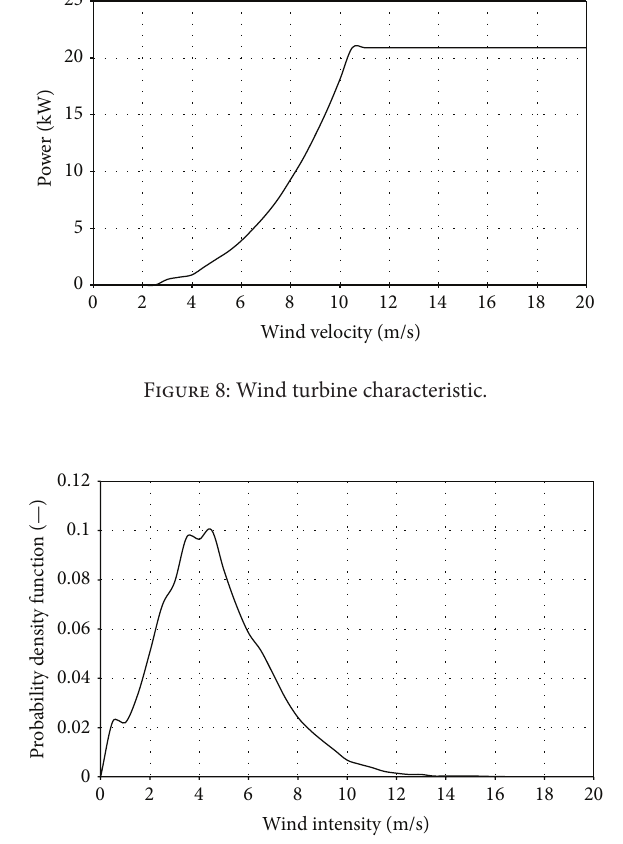
ment (Figure 12) using all the wind data (directions and the placement (Figure 13) using the dominant wind data both cases the entire available terrain surface was taken